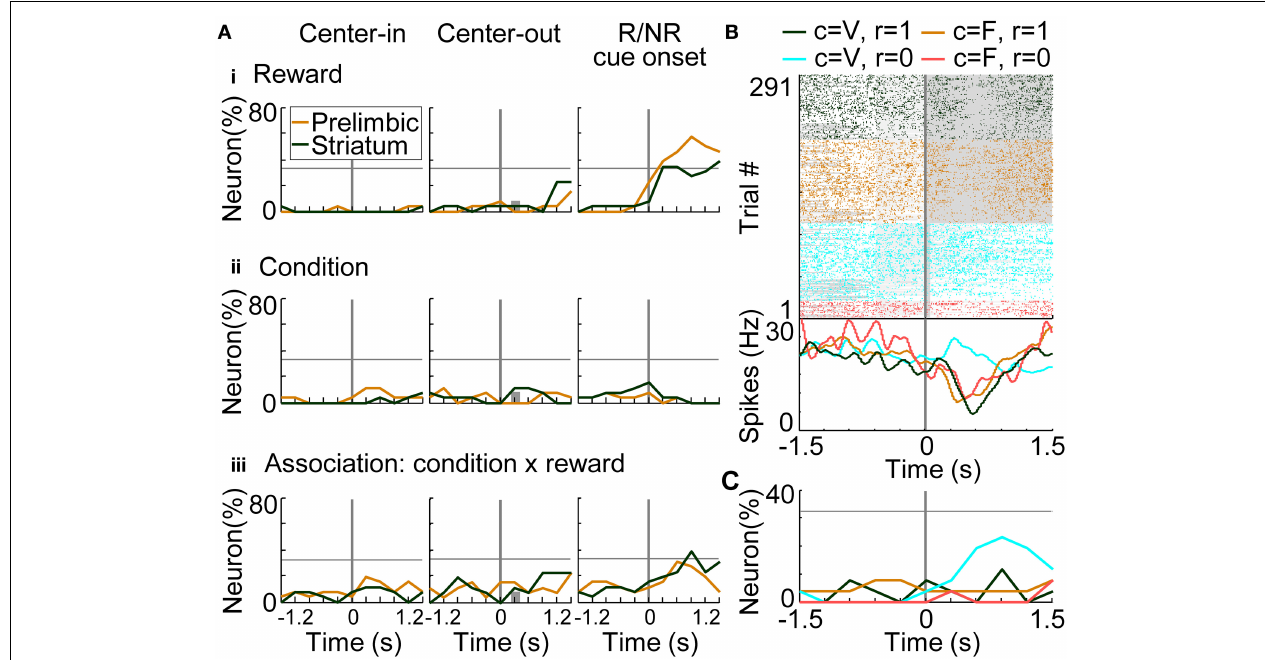
FIGURE 9 | Coding of stimulus-outcome (S-O) association. (A) Proportions of neurons coding rewards (outcomes: O) (i) , conditions (stimuli: S) (ii) and S-O associations (iii) . Regression analysis was performed on data from trials in which rats made a choice to the optimal side of fixed-reward condition. The proportion of neurons that had significant regression coefficients is shown: p < 0 . 01 in a two-sided Student’s t -test. Lines and symbols as in Figure 8A . (B) Representative dorsomedial striatal neuron encoding the S-O association. Neural activities at the onset of reward or no-reward cues are shown, as in the right column of (A) . Green and orange